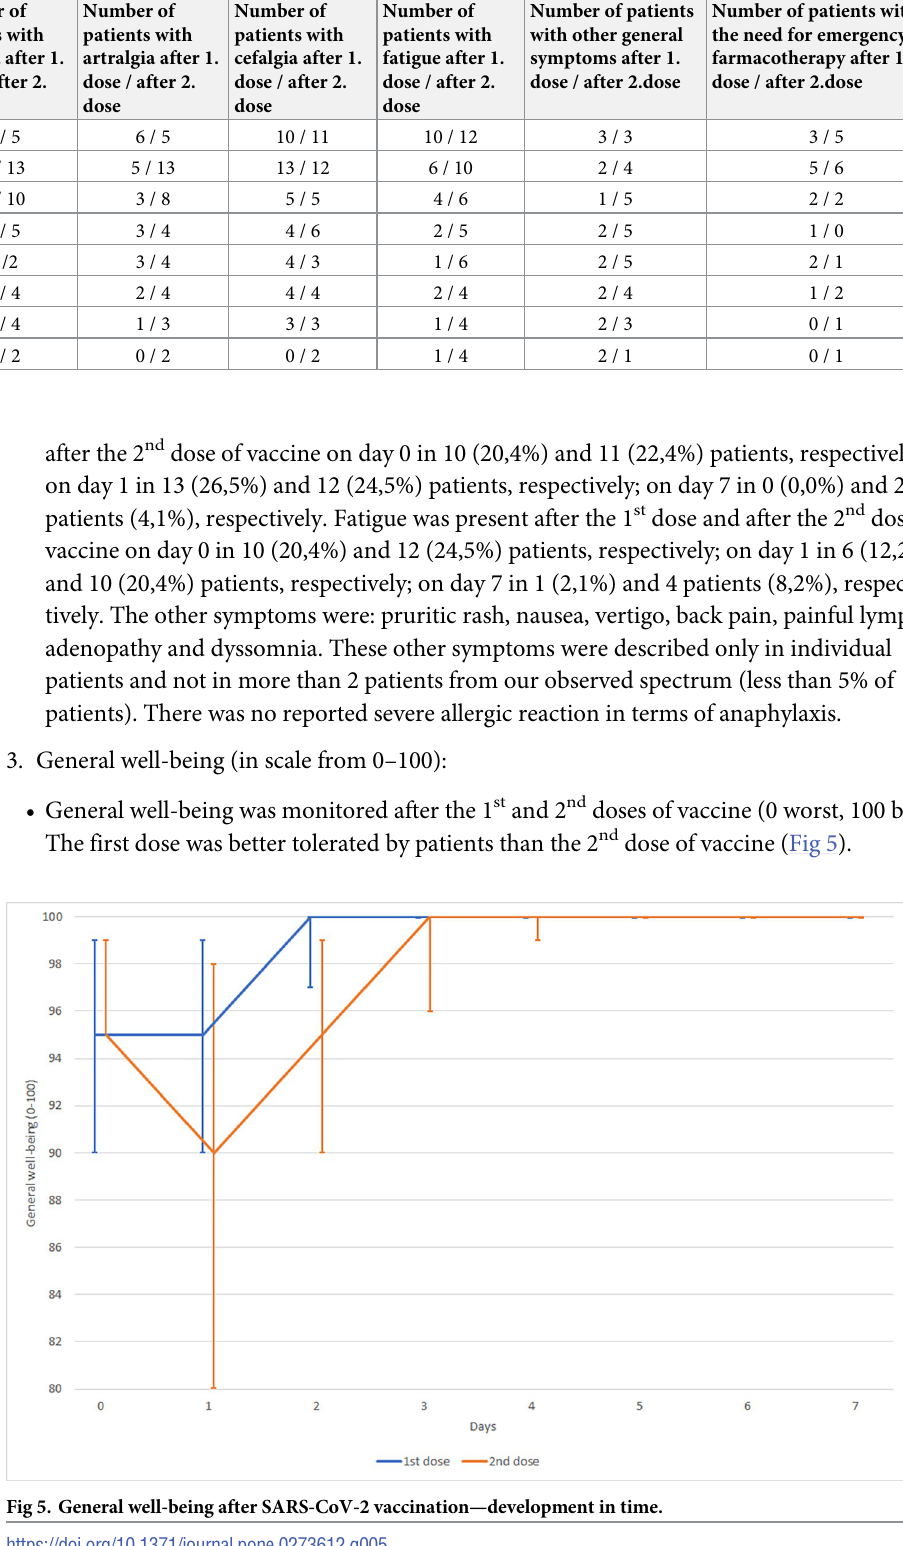
Table 3. General adverse reactions in time. Days Number of patients with body temperature � 37,0˚C in evening after 1.dose / after 2. dose